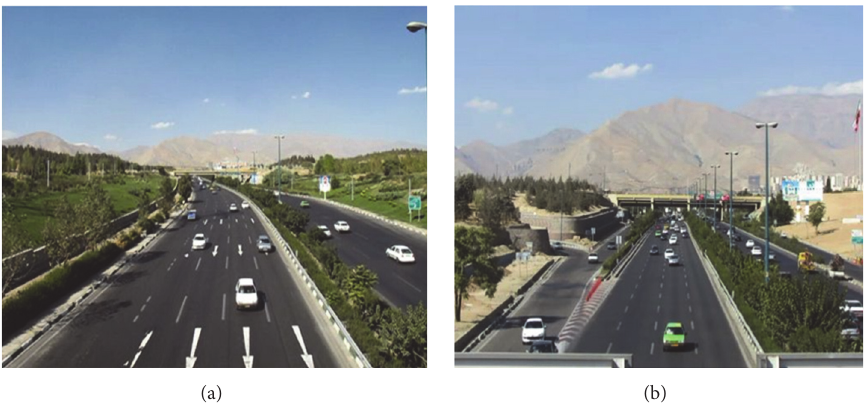
Figure 5: The areas covered by the first camera (upstream) and the second camera (downstream) are shown (b) and (a), respectively.